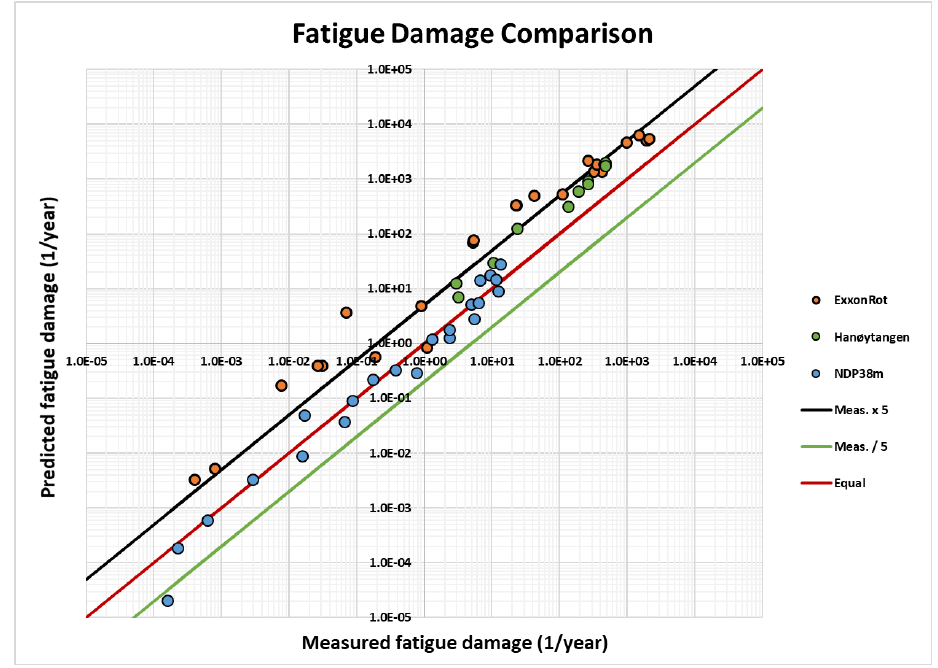
Figure 4. Fatigue prediction based on one set of hydrodynamic